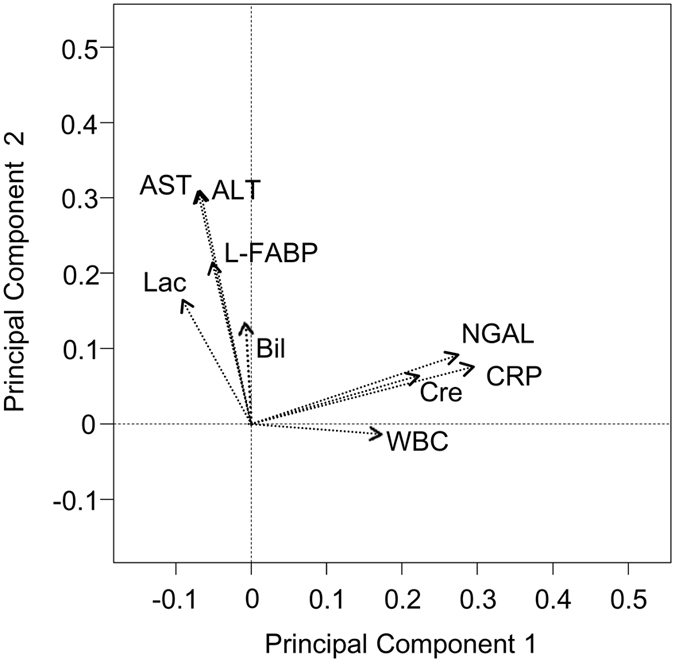
Principal component analysis of acute kidney injury (AKI) biomarkers and systemic parameters.Principal component analysis revealed different orthogonal directions between urinary NGAL and L-FABP.